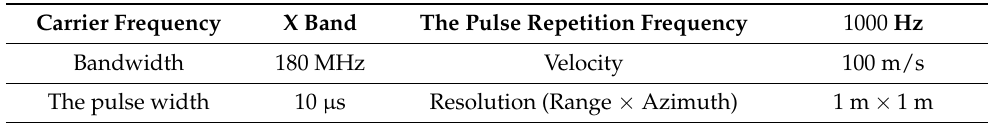
Table 3. Parameters of the airborne SAR system.